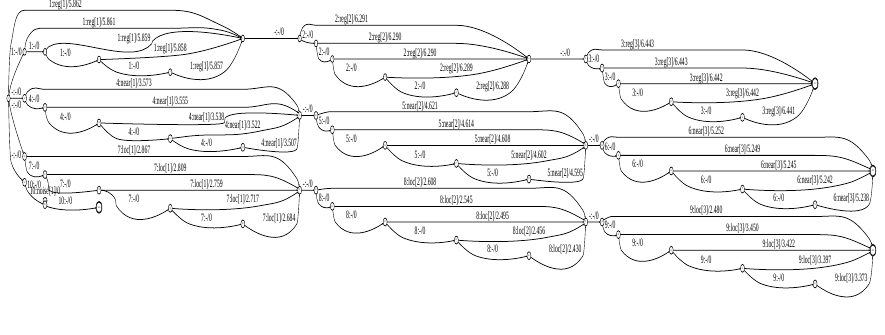
Fig. 7. Classifier design for the reevaluation of the training data. By concatenating the different HSMM states, one WFST per earthquake class is constructed (Fig. 6). The separate WFST for each class can then be unified (i.e. put in parallel) which results in one large WFST shown here. Note again that for visualization, only the first 5 paths per HSMM state are plotted.